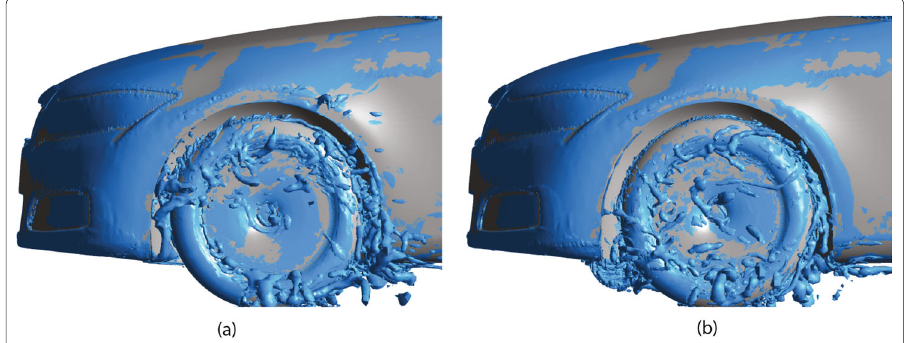
Fig. 18 Isosurfaces of the second invariant velocity gradient tensor, Q ( D / U ∞ ) 2 = 80, for U ∞ = 15 m/s ( a ) baseline, ( b ) 90 ◦ air jet with U =